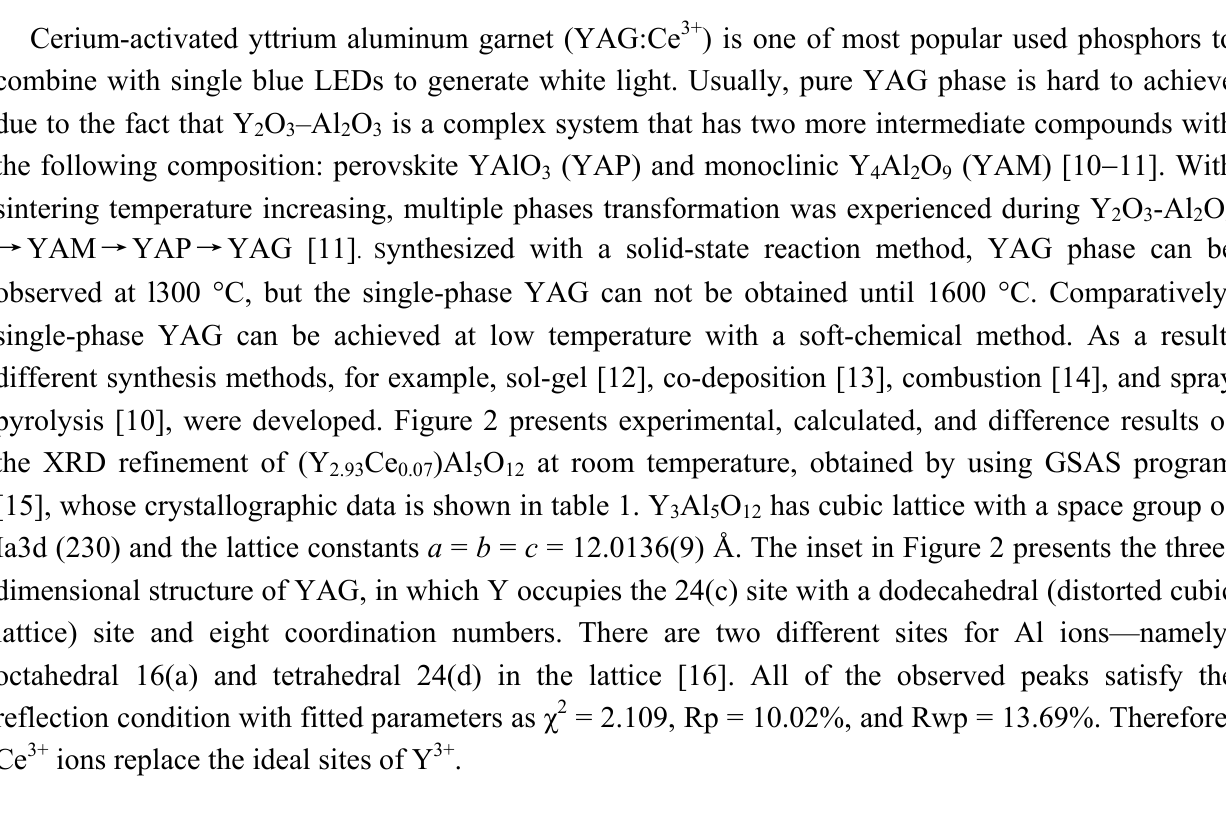
Figure 2. Experimental (crosses), calculated (solid line), and difference (bottom) results of XRD refinement of (Y